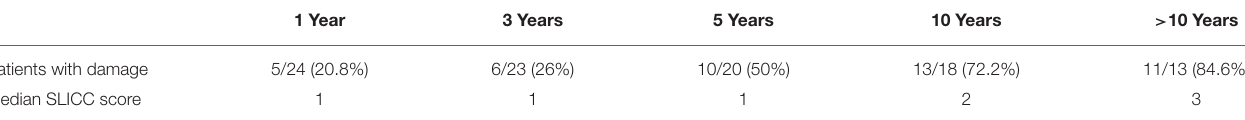
TABLE 3 | Analysis of organ damage during